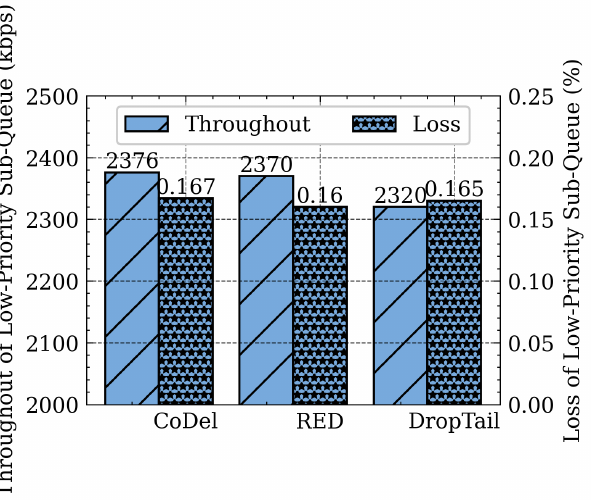
Figure 23. Different low priority sub-queue management